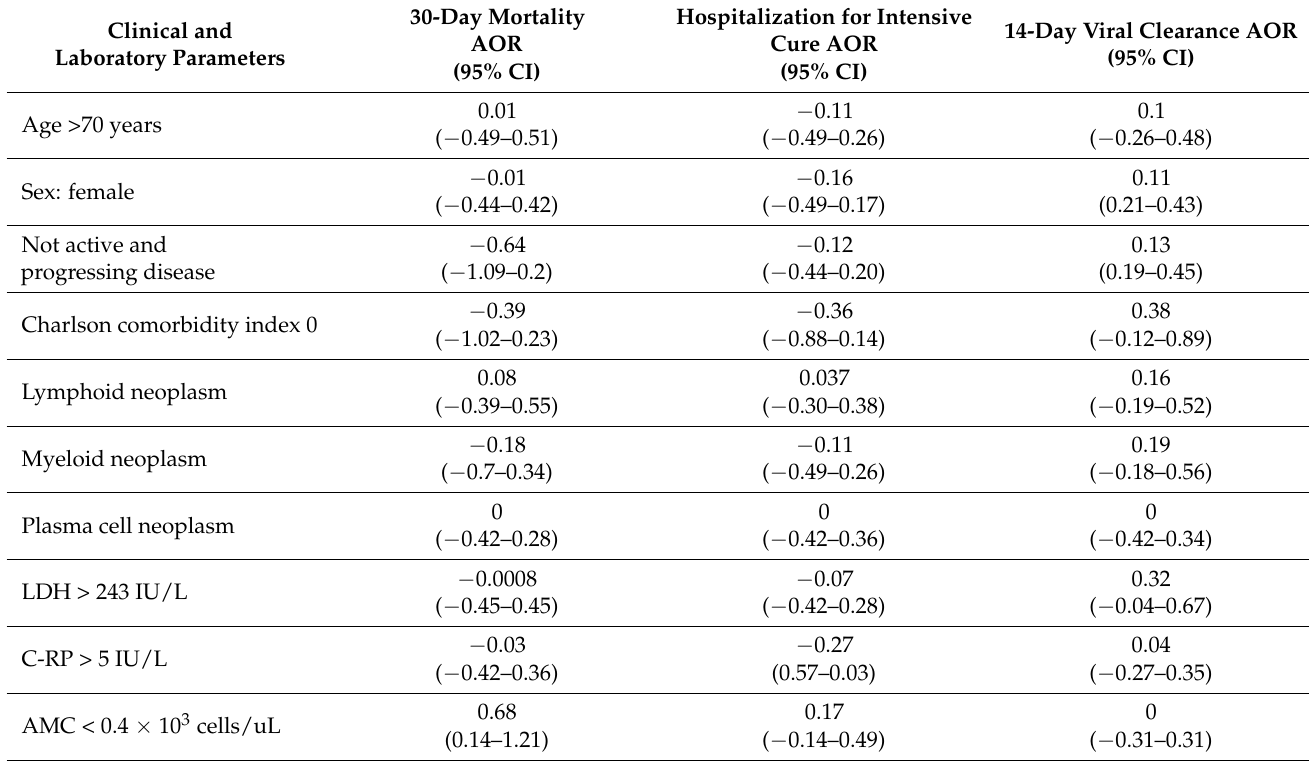
Table 4. Results of regression analysis of clinical outcomes of COVID-19 in hematological patients following